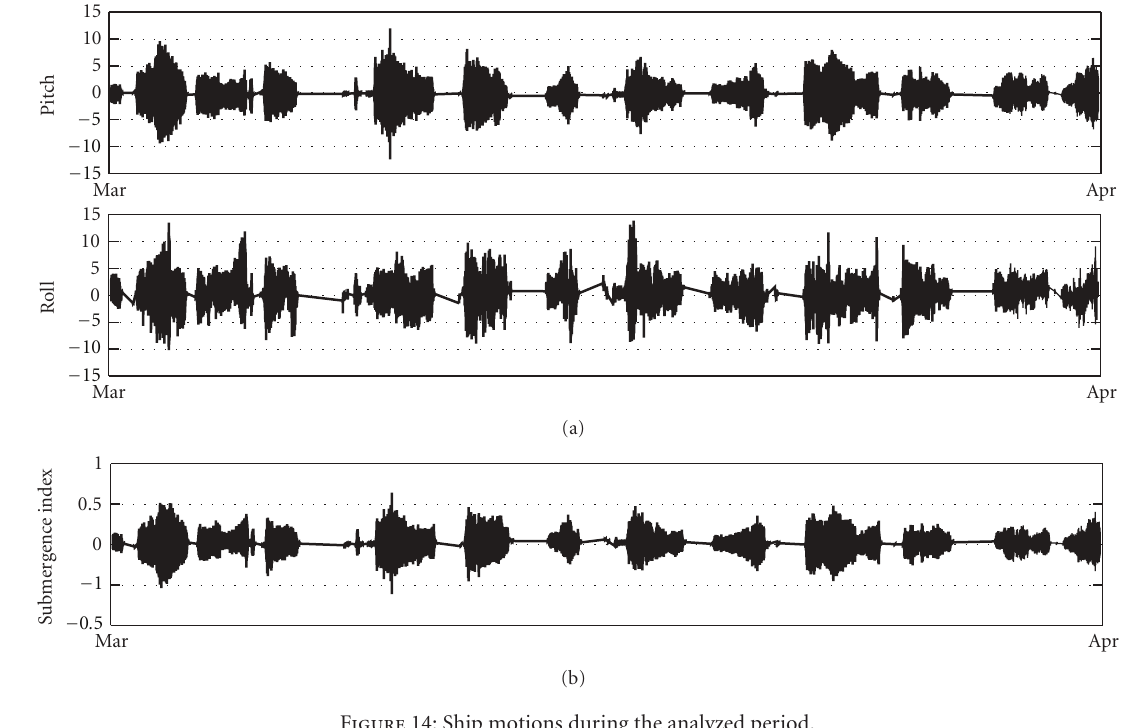
Figure 14: Ship motions during the analyzed period.